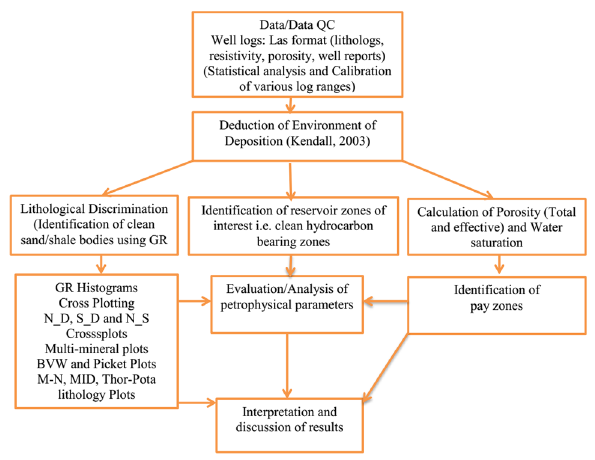
Fig. 3 Simplified workflow adopted to characterize M-field, offshore Douala Sub-Basin,